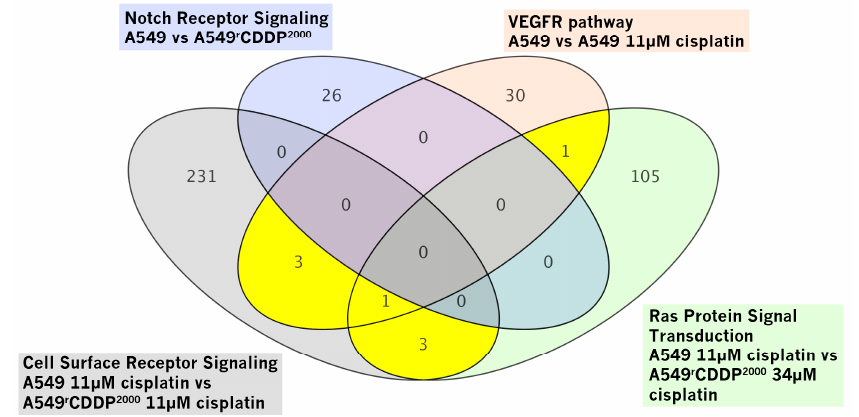
Figure 3. Venn diagram showing differentially expressed genes annotated with respective GO terms: The yellow sections indicate those genes, which were chosen for validation.